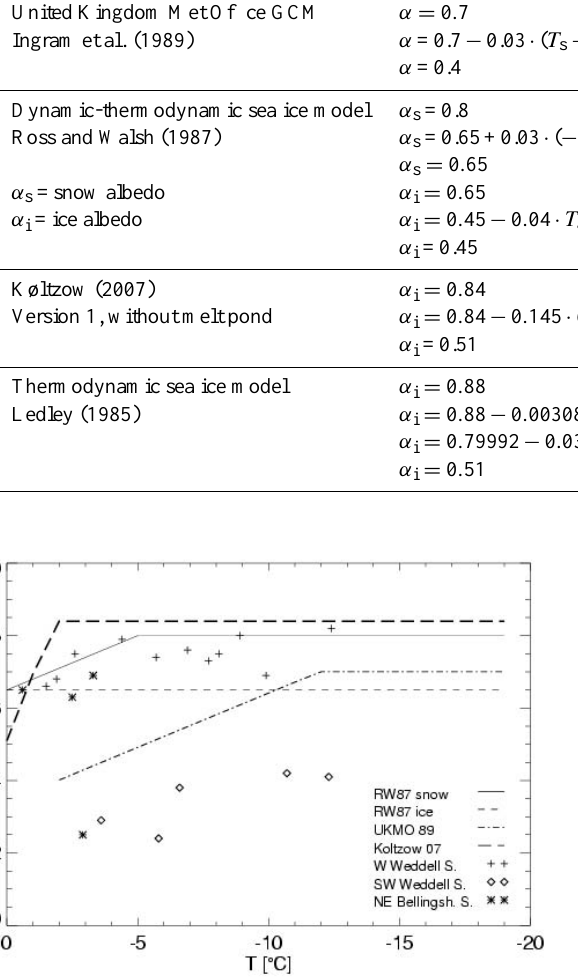
Fig. 5. Examples of albedo parameterization schemes, listed in Ta- ble 3, that use the surface temperature as a driving input param- eter: RW87 shows the albedo parameterization scheme of Ross and Walsh (1987) for snow covered and bare ice, respectively; UKMO 89 is the parameterization of the UK Met Office GC model, as described by Ingram et al. (1989) and Koltzow 07 a parameter- ization scheme for the HIRHAM model (Christensen et al., 1996), which is described by Køltzow (2007), Version 1, i.e. with the assumption of no melt pond fraction. The parameterizations are shown only for temperatures below zero degrees. Additionally shown are the averaged albedo data of this study (given in Table 1) for the western Weddell Sea ice area, south-western Weddell Sea ice area and north-eastern Bellingshausen Sea in